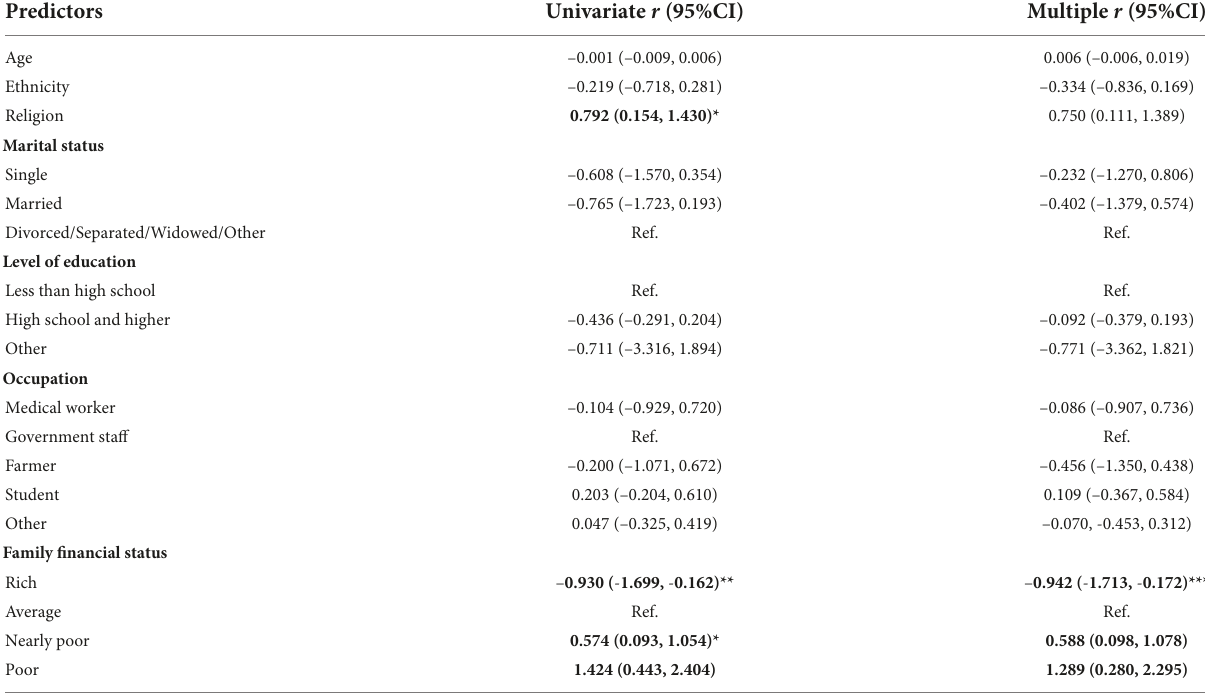
TABLE 4 Multiple linear regression model for the prediction of